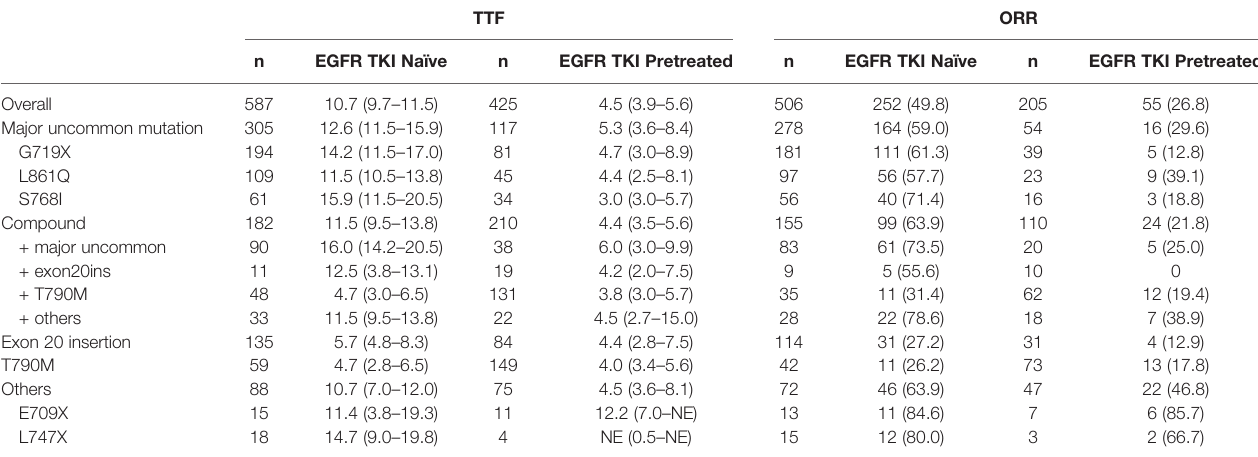
TABLE 1 | TTF and ORR with afatinib in patients with NSCLC harboring uncommon mutations.